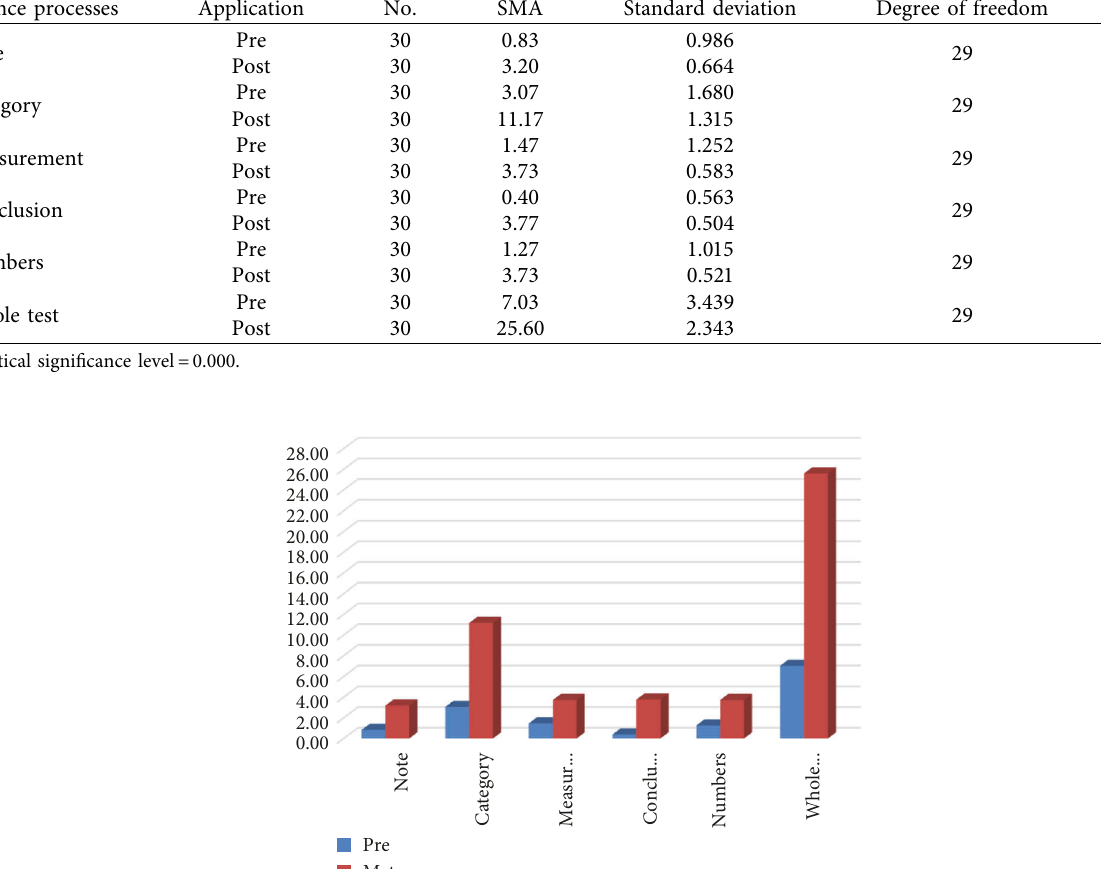
Table 8: The differences between the mean scores of children in the two applications, pre and post, of the basic science process test. Science processes Application No. SMA